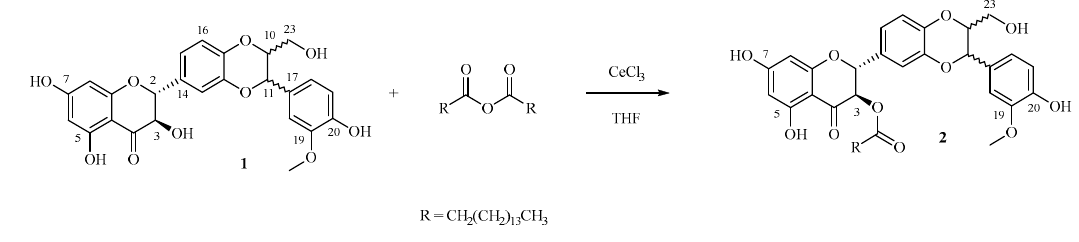
Figure 1. Scheme of the selective synthesis of 2 .